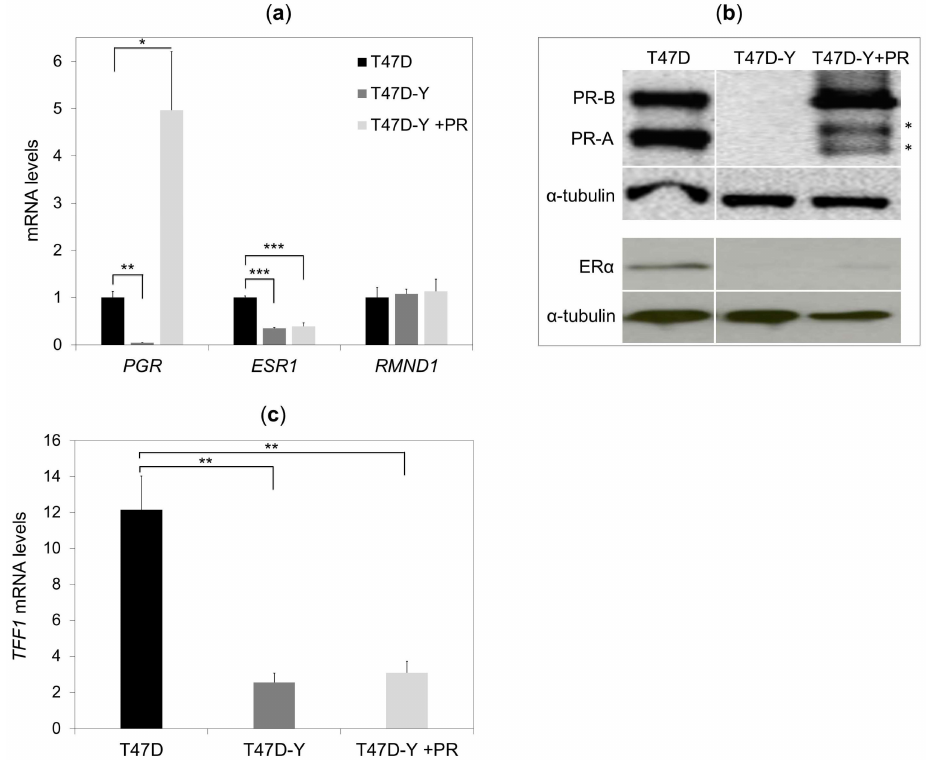
Figure 3. PR rescue of PR-deficient cells does not restore ESR1 gene expression. ( a ) Gene-specific mRNA expression measured by quantitative RT-PCR in T47D control cells, PR-deficient cells (T47D-Y) and PR-rescue cells (T47D-Y + PR). The mRNA expression levels were normalized to GAPDH expression and are represented as values relative to the T47D cells. PGR , PR-encoding gene; ESR1 , ER-encoding gene. Error bars represent the SD of three independent experiments. * p less than or equal to 0.05, ** p less than or equal to 0.01, *** p less than or equal to 0.005, unpaired two-tailed Student’s t -test. ( b ) Gene-specific protein levels measured by Western blotting in T47D control cells, T47D-Y and T47D-Y + PR cells. The lanes T47D and T47D-Y of this image are the same as in Figure 1b and are shown here for comparison with T47DY +PR. Blots are representative of three independent experiments. * indicates the degradation products of PR-B isoform. ( c ) PR rescue of PR-depleted cells does not restore the estrogen-mediated gene expression. T47D, PR-deficient cells (T47D-Y) and PR-rescue (T47D-Y + PR) cells were treated with estradiol (E2, 10 nM) or ethanol (vehicle) for 6 h, at which point, TFF1 mRNA expression levels were measured by quantitative RT-PCR. Gene-specific expression levels were normalized to GAPDH expression and are represented as values relative to the vehicle (E2/vehicle). Error bars represent the SD of three independent experiments. ** p less than or equal to 0.01, unpaired two-tailed Student’s t